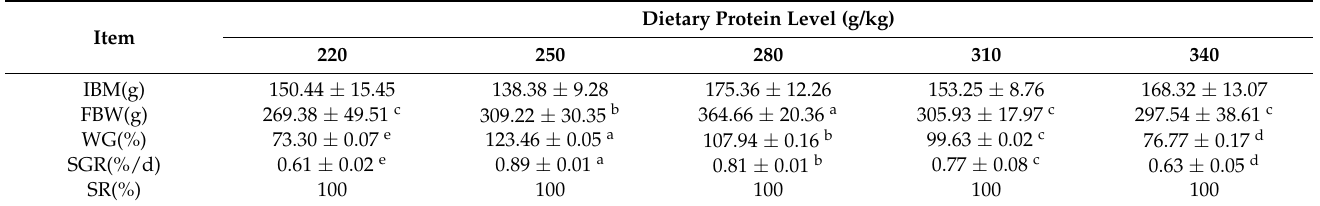
Table 1. Effects of different dietary protein levels on the growth performance of Cyprinus car- pio haematopterus